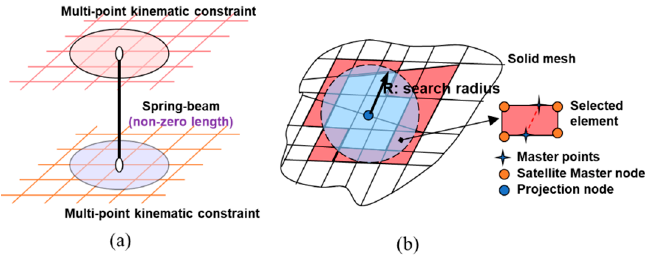
Figure 14. Beam model: ( a ) spring-beam element connection between the two surfaces, ( b ) multi-point kinematic constraint.